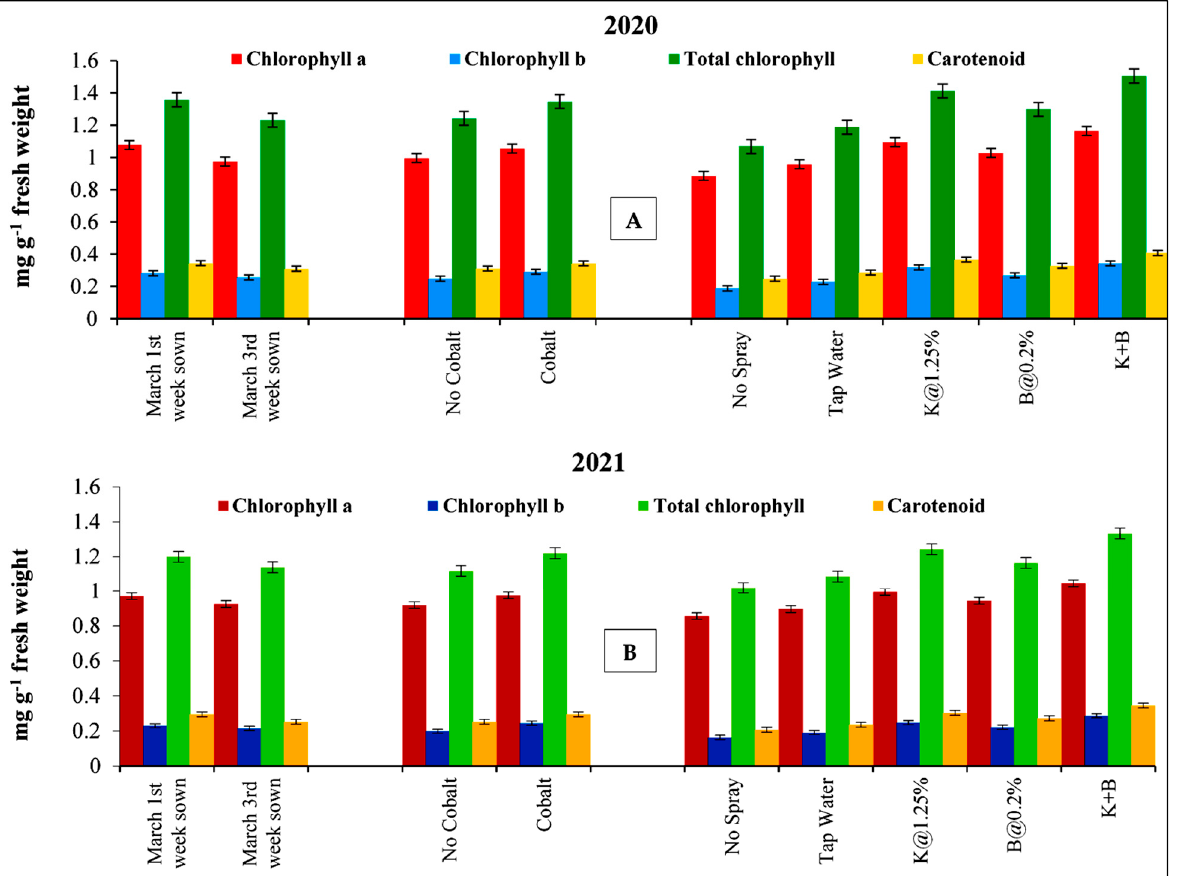
Figure 4. Chlorophyll a, chlorophyll b, total chlorophyll, and carotenoid contents of black gram leaves under different dates of sowing and different nutrient applications during crop season: ( A ) 2020 and ( B ) 2021 (error bars are representing the standard error of the mean). Table 9. Proline content, nitrate reductase content, and cell membrane stability of black gram under different dates of sowing and different nutrient applications.